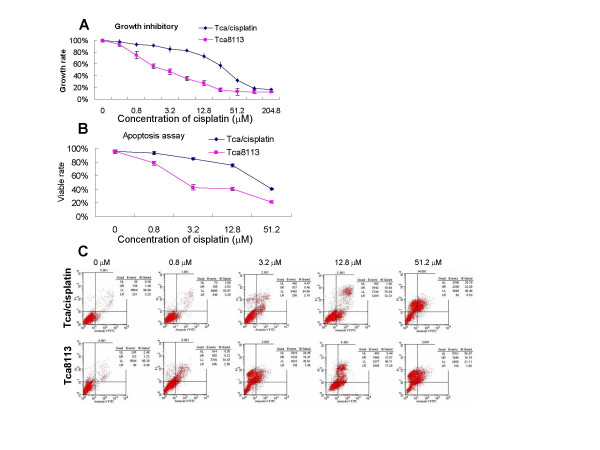
Response of Tca/cisplatin and Tca8113 cells to cisplatin. A: Dose-growth rate curve plotted from the MTT assay results. Both cell lines displayed dose-dependent growth inhibition, but the Tca/cisplatin cells were more resistant to the antiproliferative activity of cisplatin (P = 0.0000, ANOVA analysis). Each point was the mean of six independent experiments. B: Dose-viability curve was plotted from the Annexin-V/PI assay results. There was a dose-dependent decrease in viability in both cell lines, but the decrease was more rapid in the Tca8113 cells (P = 0.0000, ANOVA analysis). Each point was the mean of three independent experiments. C: Scatter plots of Annexin V/PI staining. As the cisplatin dose increased, the apoptosis rates (UR+LR) also gradually increased, but the increase was more rapid in Tca8113 cells than in Tca/cisplatin cells (P = 0.0000, ANOVA analysis). Each figure represents three independent experiments.